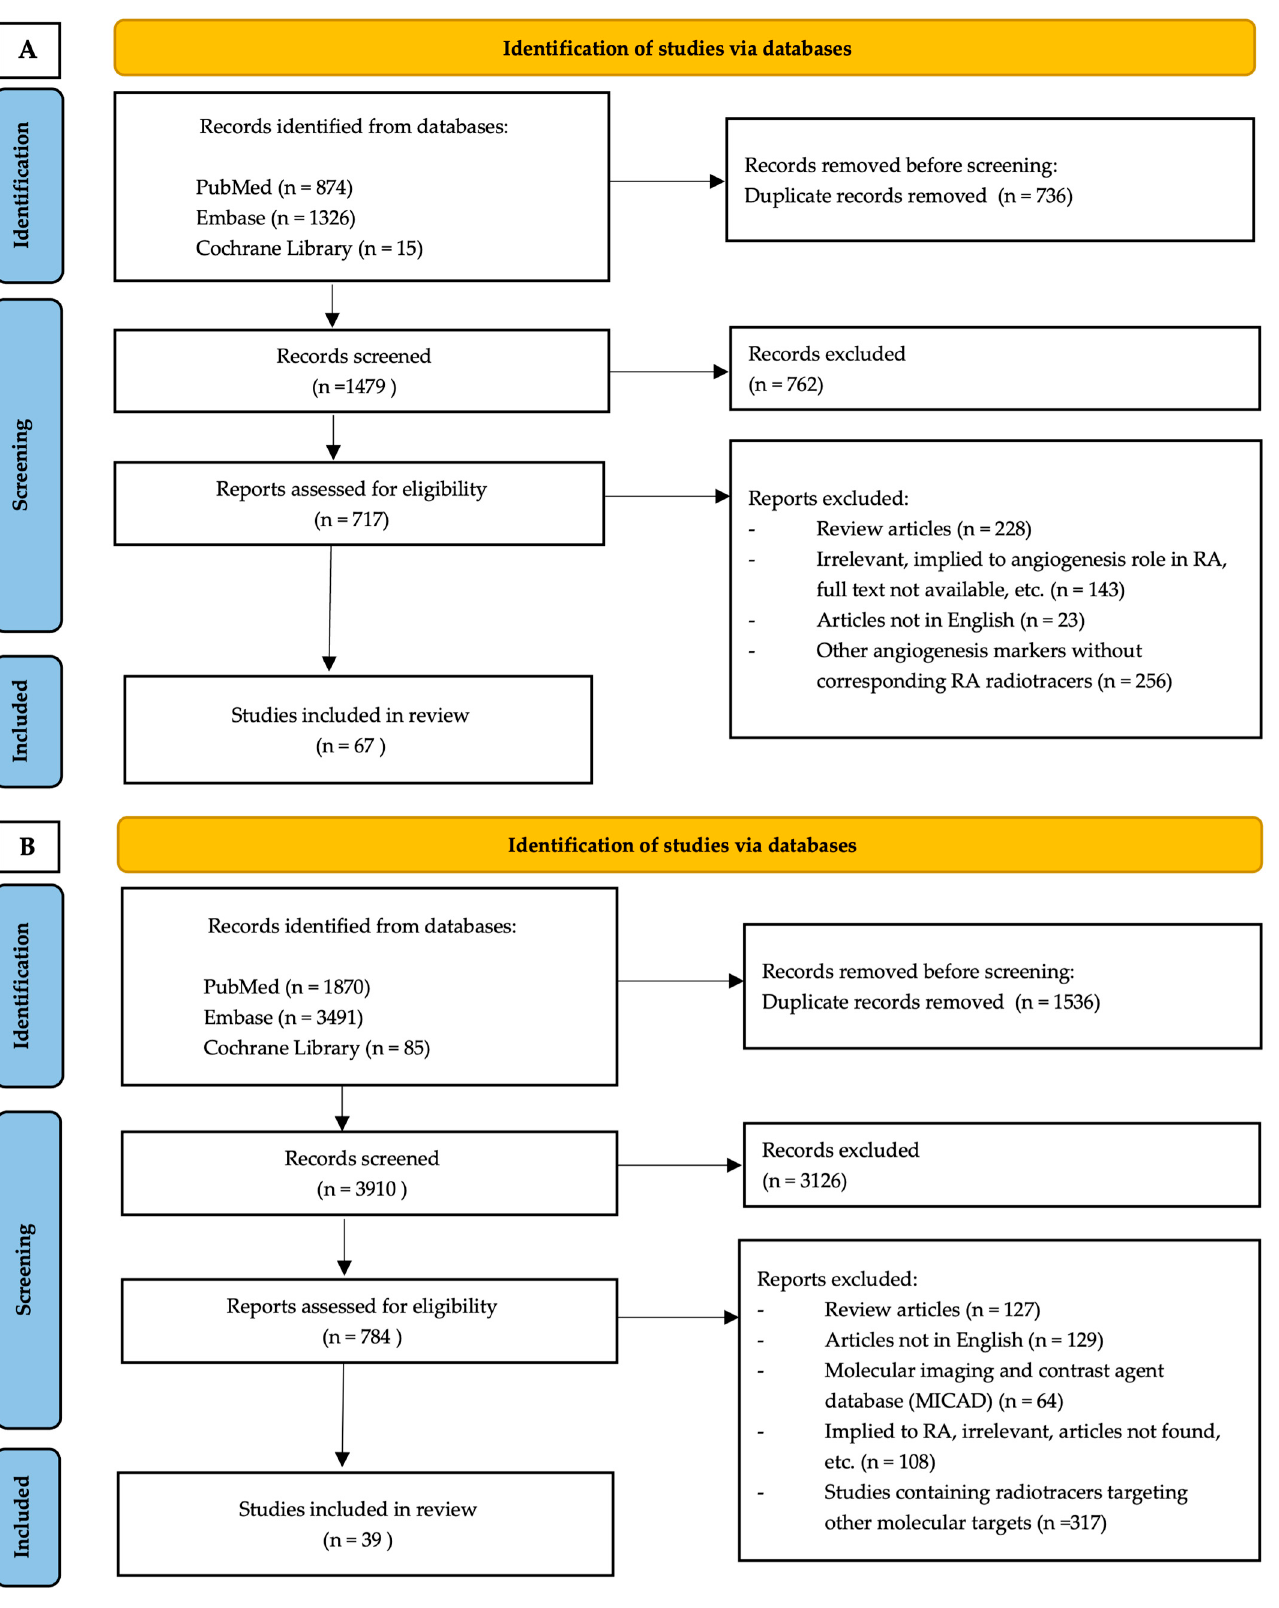
Figure 3. The flow diagram of the search and selection procedure of studies. ( A ) Overview of the articles found during the search for RA-angiogenesis targets. ( B ) Overview of the articles found during the search for nuclear imaging tracers in RA.